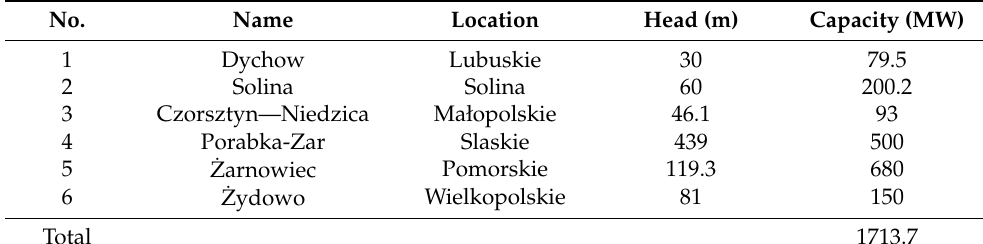
Table 1. Pumped Hydroelectric Energy Storage power plants in Poland